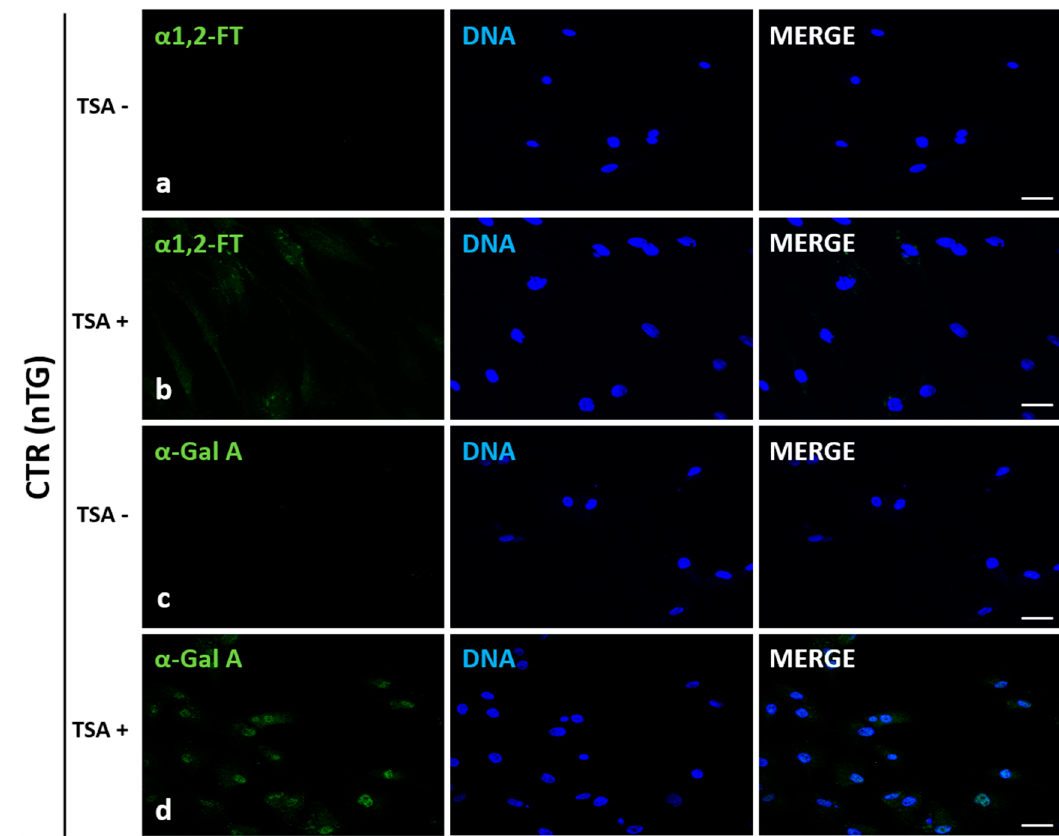
Figure 3. Immunofluorescence analysis of in vitro cultured porcine ACFCs treated (TSA + ) ( b , d ) and not treated with trichostatin A (TSA − ) ( a , c ). Representative microphotographs of immunofluorescence localization of human α 1,2-fucosyltransferase ( α 1,2-FT; a , b ) and α -galactosidase A ( α -Gal A; c , d ) in ACFCs derived from non-transgenic pigs (CTR nTG). Immunofluorescent staining with Alexa Fluor 488-labelled secondary antibodies (green fluorescence) and 4 ′ ,6-diamidino-2-phenylindole (DAPI)-mediated counterstaining of cell nuclei (blue fluorescence). Scale bars represent 100 μ m. Immunoreaction was performed on in vitro-cultured porcine ACFCs from at least three pigs of each experimental group. The TSA + cells exhibited a more intense signal for both α 1,2-FT and α -Gal A proteins in control group (CTR nTG) ( b , d ). No positive signal stemming from α 1,2-FT and α -Gal A in the TSA − control (CTR nTG) was noticed ( a , c ).